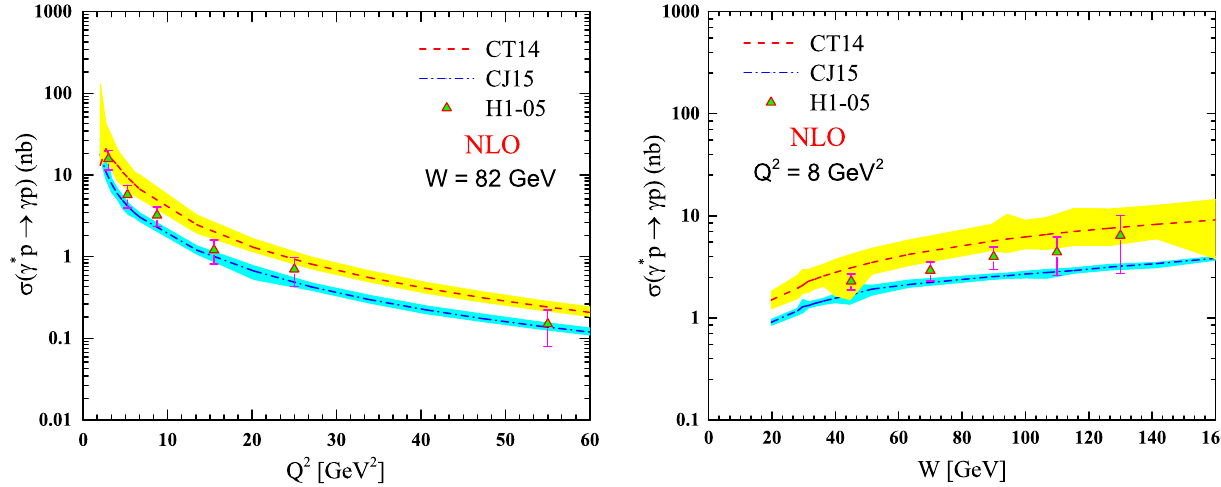
Fig. 5 The DVCS γ ∗ p → γ p cross section as a function of Q 2 (left) and W (right). Our NLO pQCD results are compared to the 2005 H1 data [77]; see for details Fig.